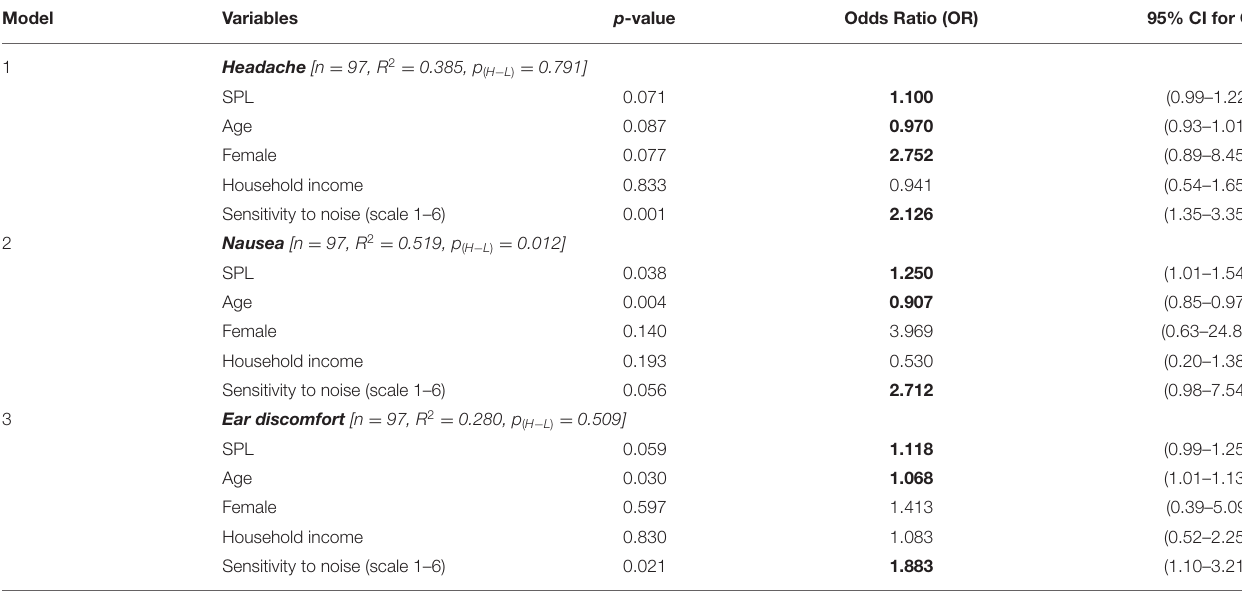
TABLE 5 | Association among health problems, WTN (SPLs), and covariates in Variant 2.